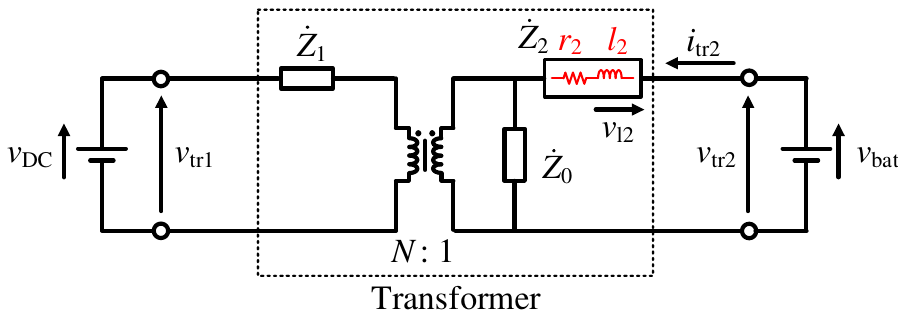
Figure 7. Equivalent circuit of DAB converter in Section B of Figure